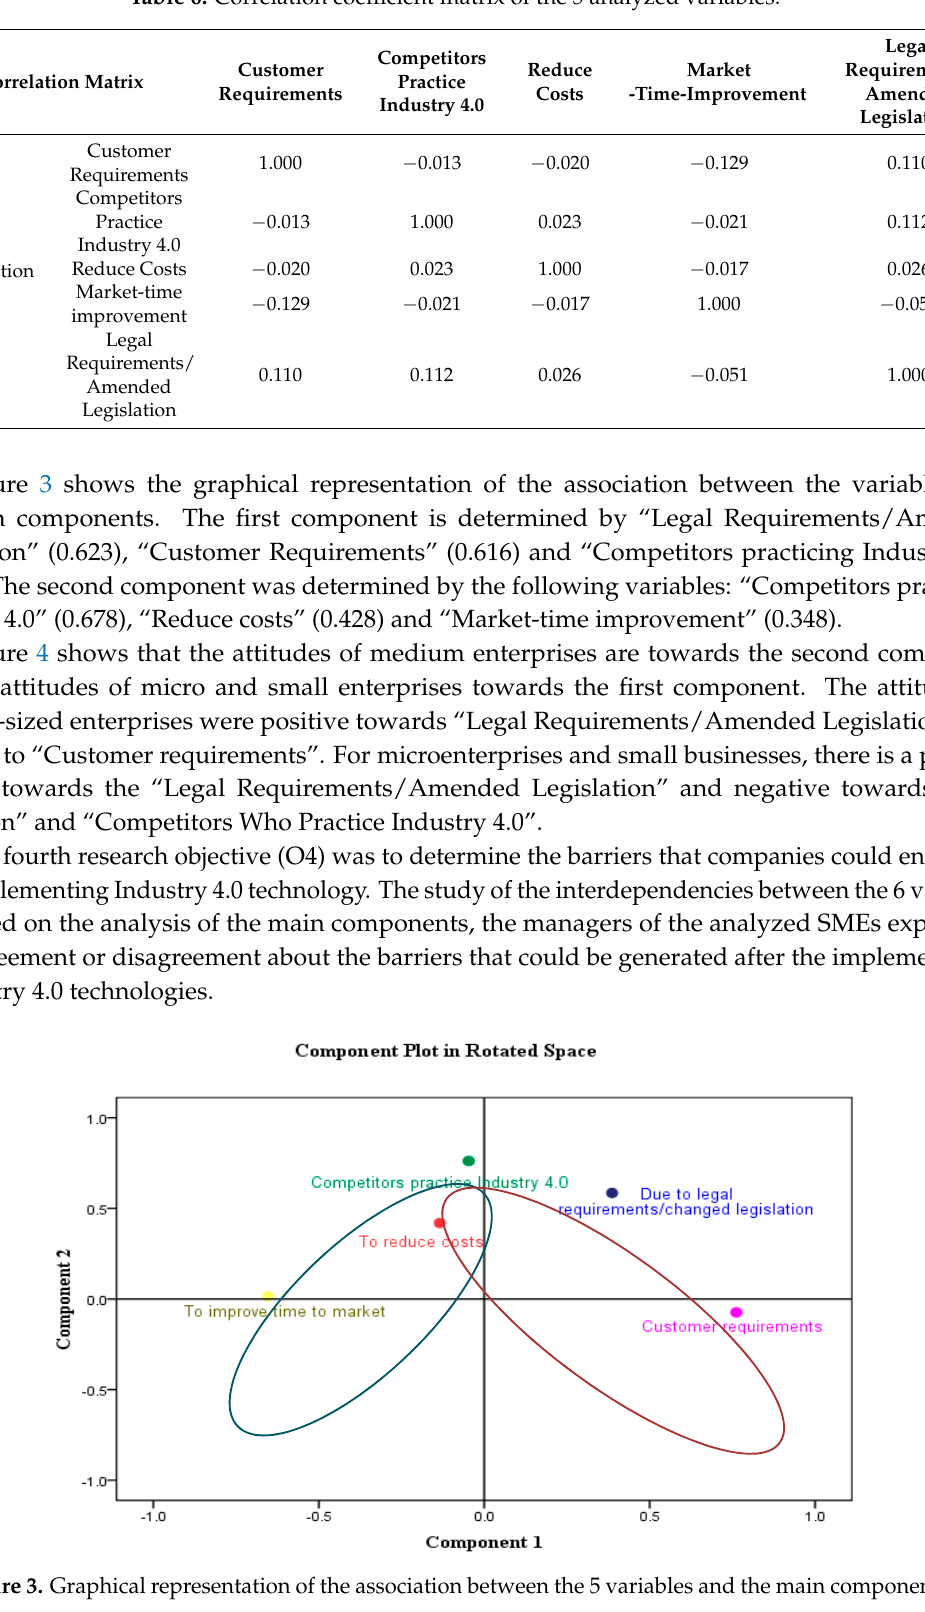
Figure 4. Representation of SMEs by size in the two main components.